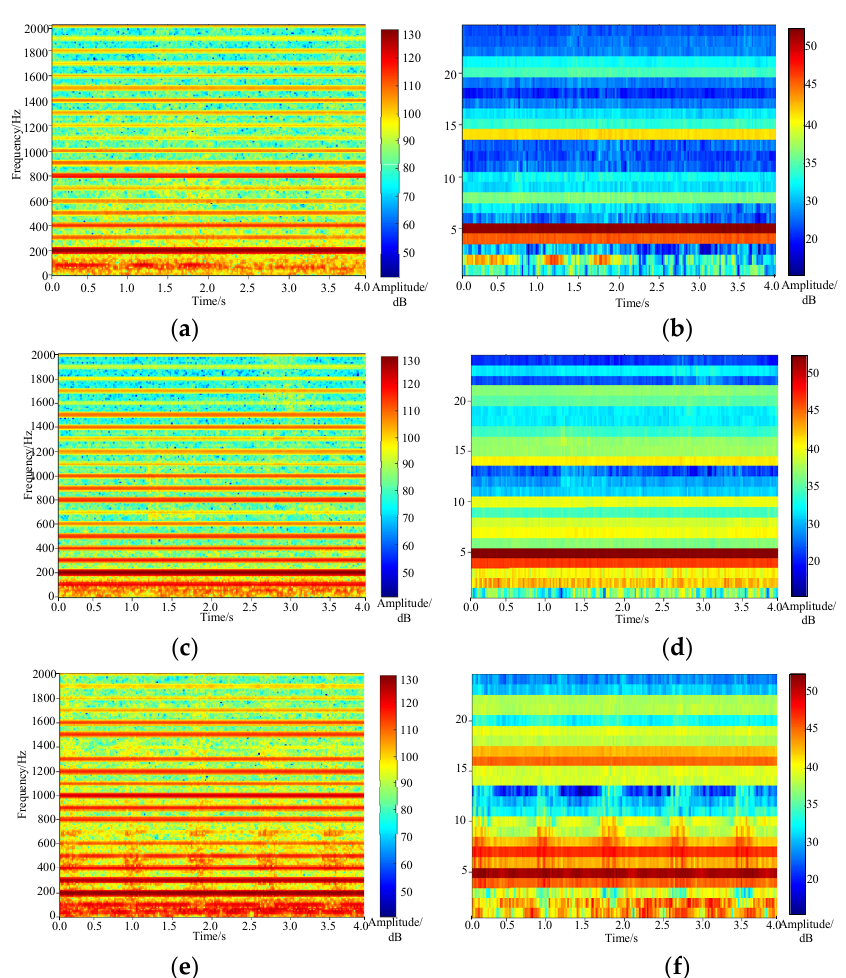
Figure 12. Time–frequency spectrum distribution of three operating states. ( a ) Acoustic time–frequency spectrum of rated compression ( b ) Mel time–frequency spectrum of rated compaction ( c ) Acoustic time–frequency spectrum when winding loosens ( d ) Mel time–frequency spectrum when winding loosens ( e ) Acoustic time–frequency spectrum when pad falls off ( f ) Mel time–frequency spectrum when pad falls off.